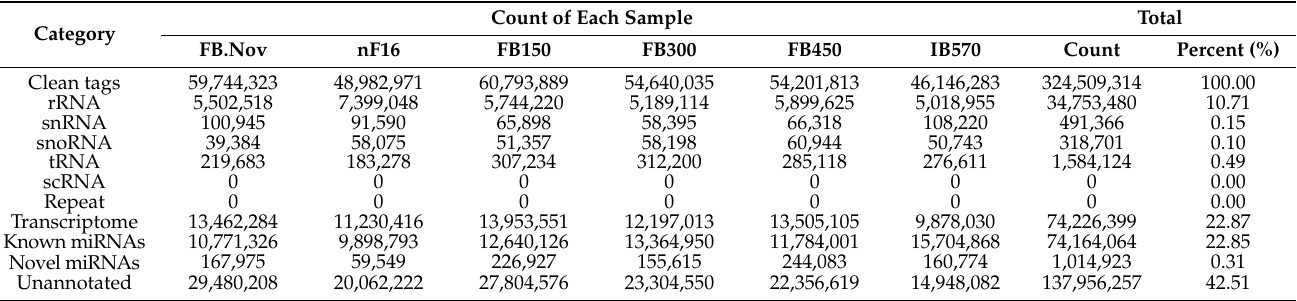
Table 1. Annotation and classification of small